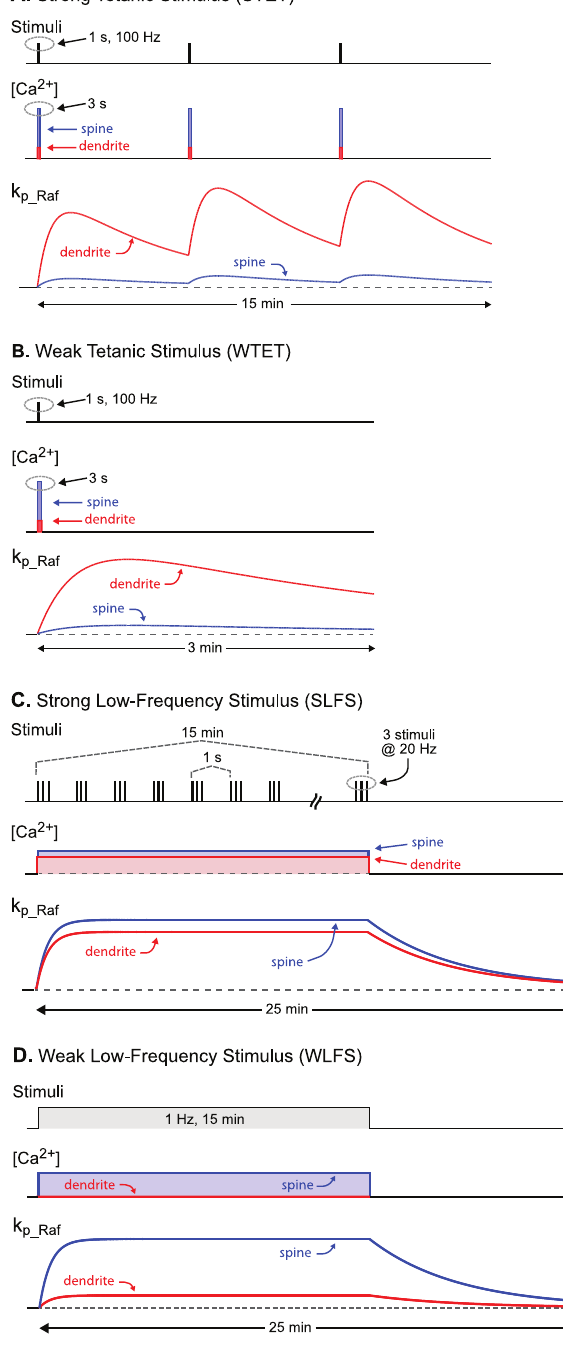
Figure 9. Schematic representations of the electrical stimulus protocols in the present study. A , STET is three 100 Hz bursts of electrical stimuli. The inter-burst interval is 5 min. Each burst is simulated as a 3-s increase of [Ca 2 + ] s and [Ca 2 + ] d . Each tetanus increases k p_Raf,s and k p_Raf,d , and some summation of these increases is evident. B , WTET is a single 100 Hz burst. C , SLFS is a series of bursts, each of three stimuli at 20 Hz, with an inter-burst interval of 1 s, continuing for 15 min. This is simulated as a 15-min increase of [Ca 2 + ] s and [Ca 2 + ] d , and an increase of k p_Raf,s and k p_Raf,d . that lasts , 25 min. D , WLFS is a 15- min train of single stimuli at 1